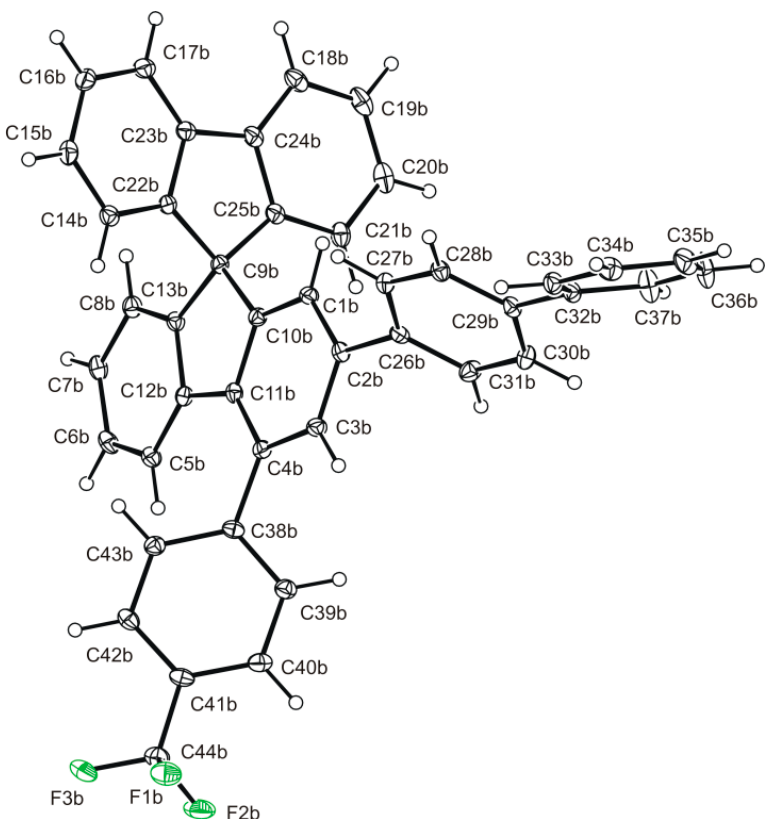
Figure 2. ORTEP drawing of 9g with 50% probability.